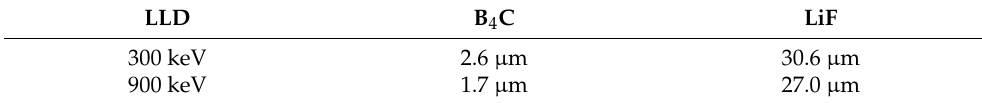
Table 1. Optimal converter layer thicknesses for B 4 C and LiF [30].